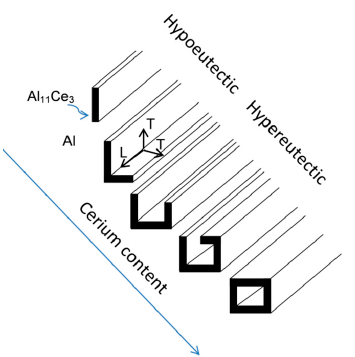
Figure 10. Schematic showing the effect of Ce content on morphology of the Al 11 Ce 3 eutectic phase. The lateral growth direction is marked with L and the transverse growth direction is marked with T.